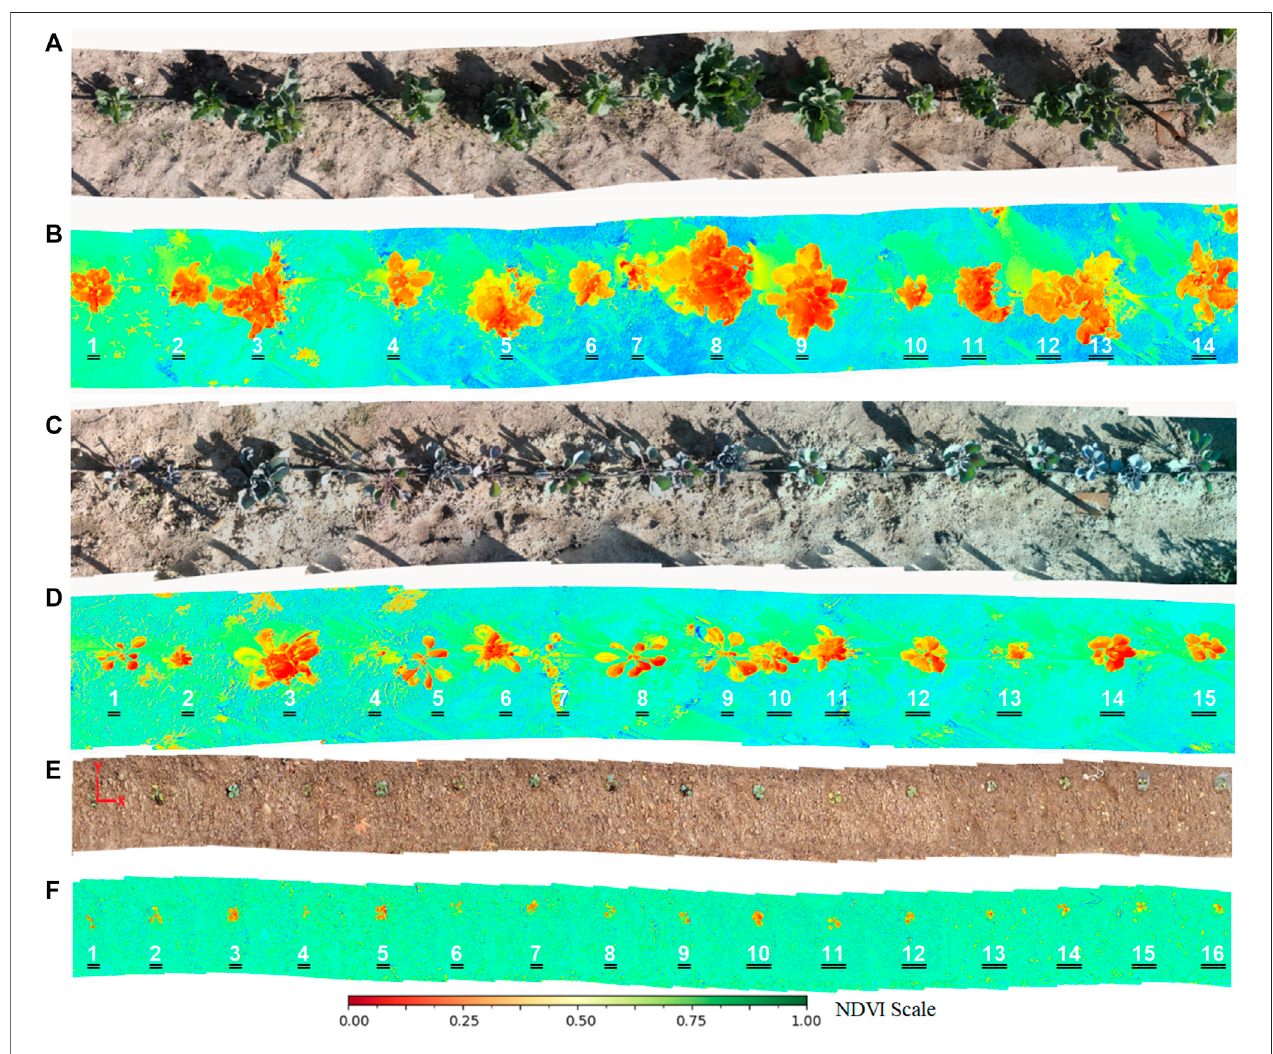
FIGURE 4 | Rgb (A,C,E) and Multispectral (B,D,F) crop row mosaics.